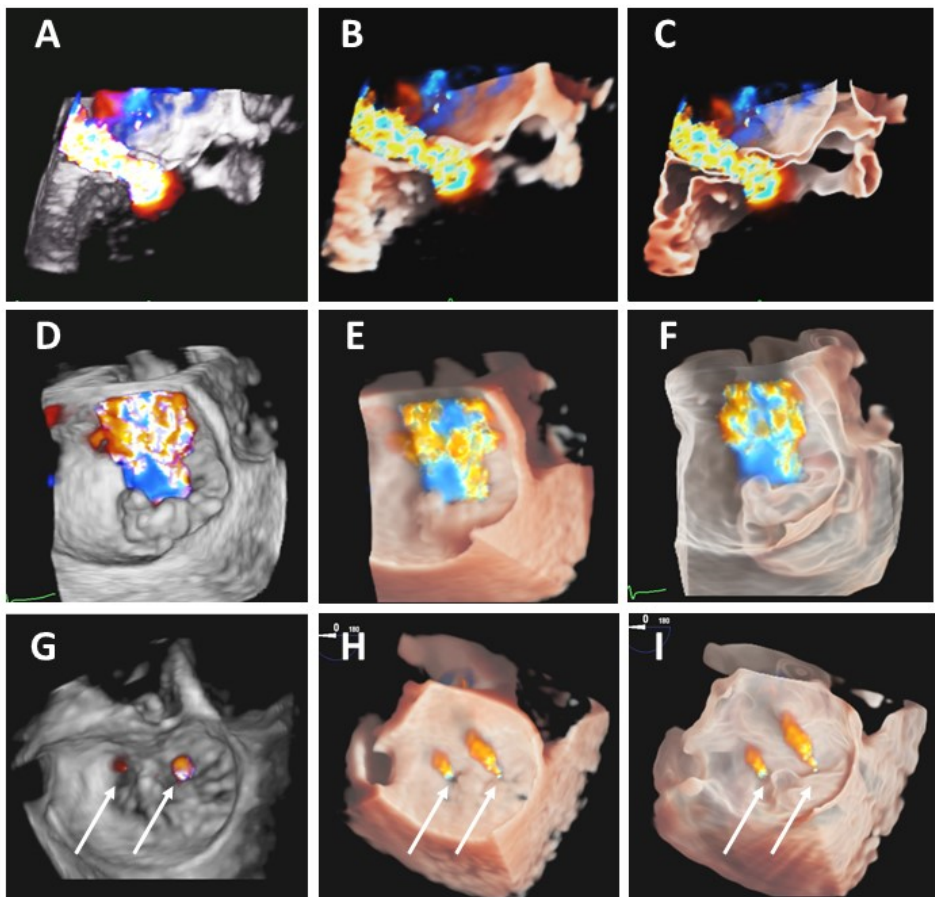
Figure 4. Head-to-head comparisons between standard 3DTEE (3DTs, left panels), transillumination (3DTr, central panels) and glass feature (3DGl, right panes) merged with color Doppler rendering in a case of mitral valve regurgitation due to P2 prolapse before and after a Mitra-clip implantation. In panels A – C longitudinal view of color jet and flow acceleration shape for calculation of effective regurgitant orifice area using 3D proximal isovelocity surface area. In panels D – F , 3DTr and 3DGl improve delineation of the borders of the MV regurgitant orifice in the surgical view of the valve. In the lower panels G – I post-procedural reconstructions after the implantation of a central clip demonstrating the more defined identification of 2 residual color jets with transillumination and transparency modalities (arrows).